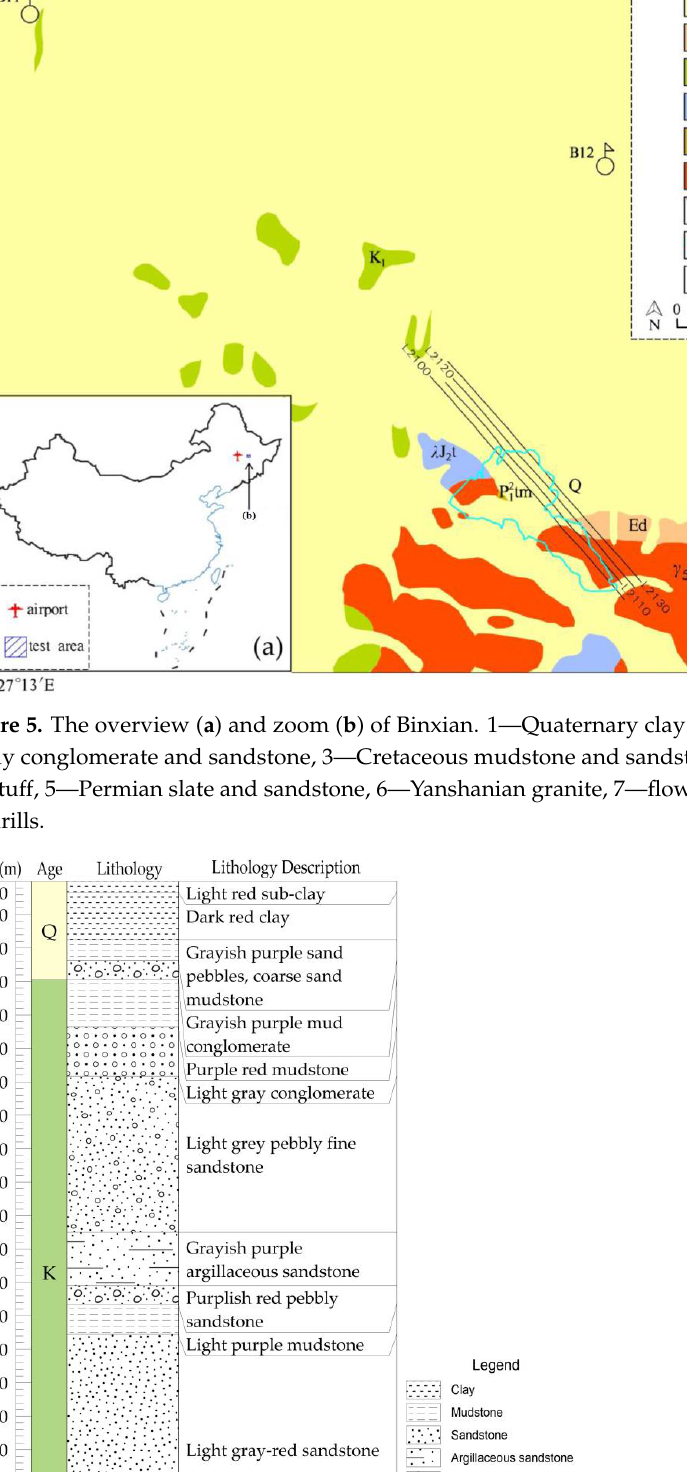
Table 2. iFTEM-I system parameters for the test flight in Binxian. Parameters